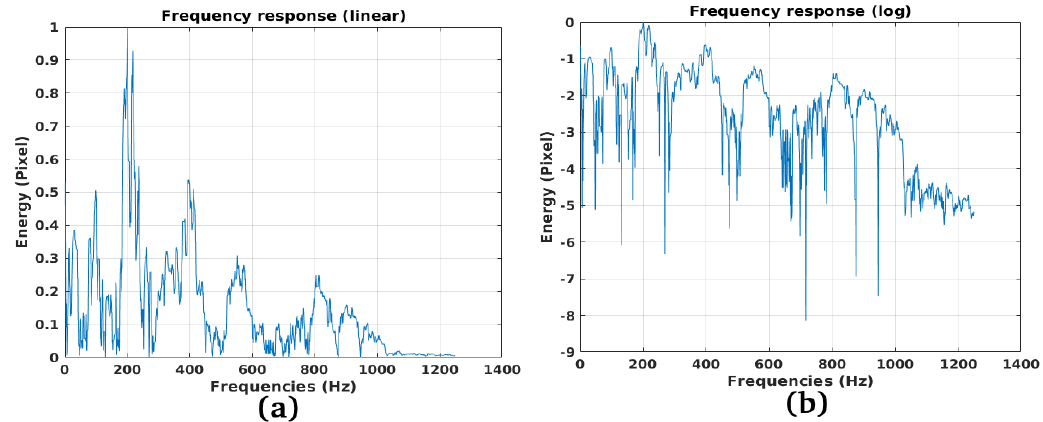
Figure 31. Vibration spectrum trend of P2 (DFT of Figure 29b): ( a ) Linear trend, ( b ) Logarithmic